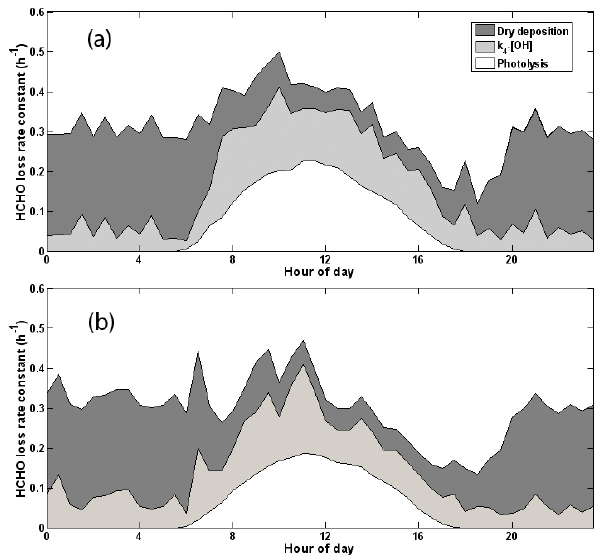
Fig. 9. Mean diurnal variations of the first order HCHO loss rate constants (h − 1 ) for photolysis ( j 1a + j 1b ) (white), reaction with OH ( k 4 · [OH]) (light gray), and dry deposition (dark gray) in (a) HCHO High period and (b) HCHO Low period of BEARPEX